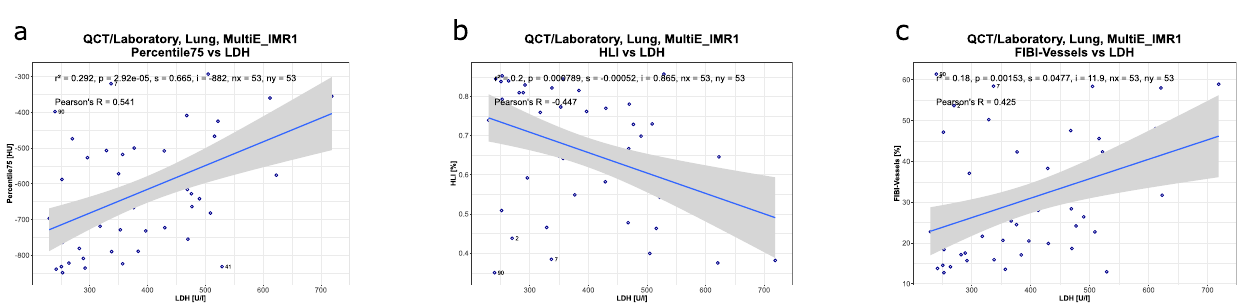
Fig 3. Correlations between LDH and QCT parameters with highest Pearson‘s r for 75 th lung percentile in comparison to HLI -700 and FIBI -700 .